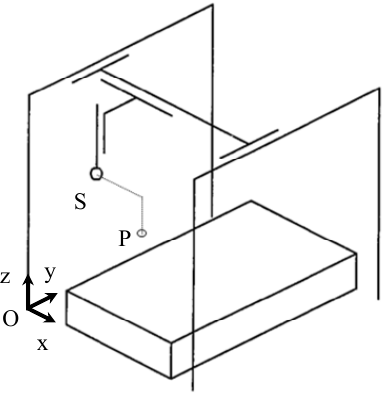
Figure 6. Structure of the studied linear axes.